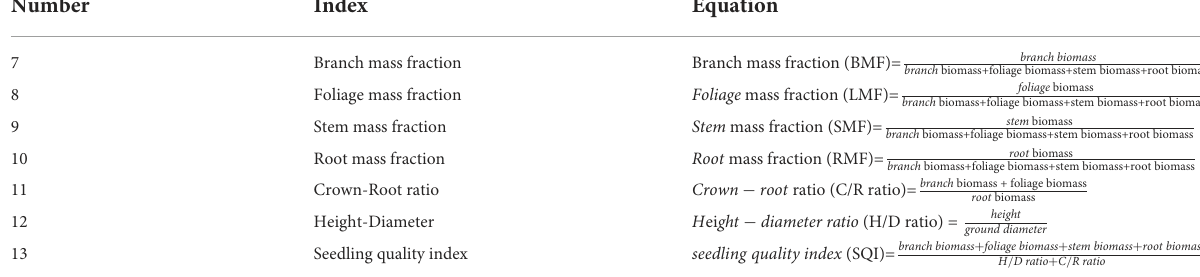
TABLE 3 Equations for calculating biomass allocation of